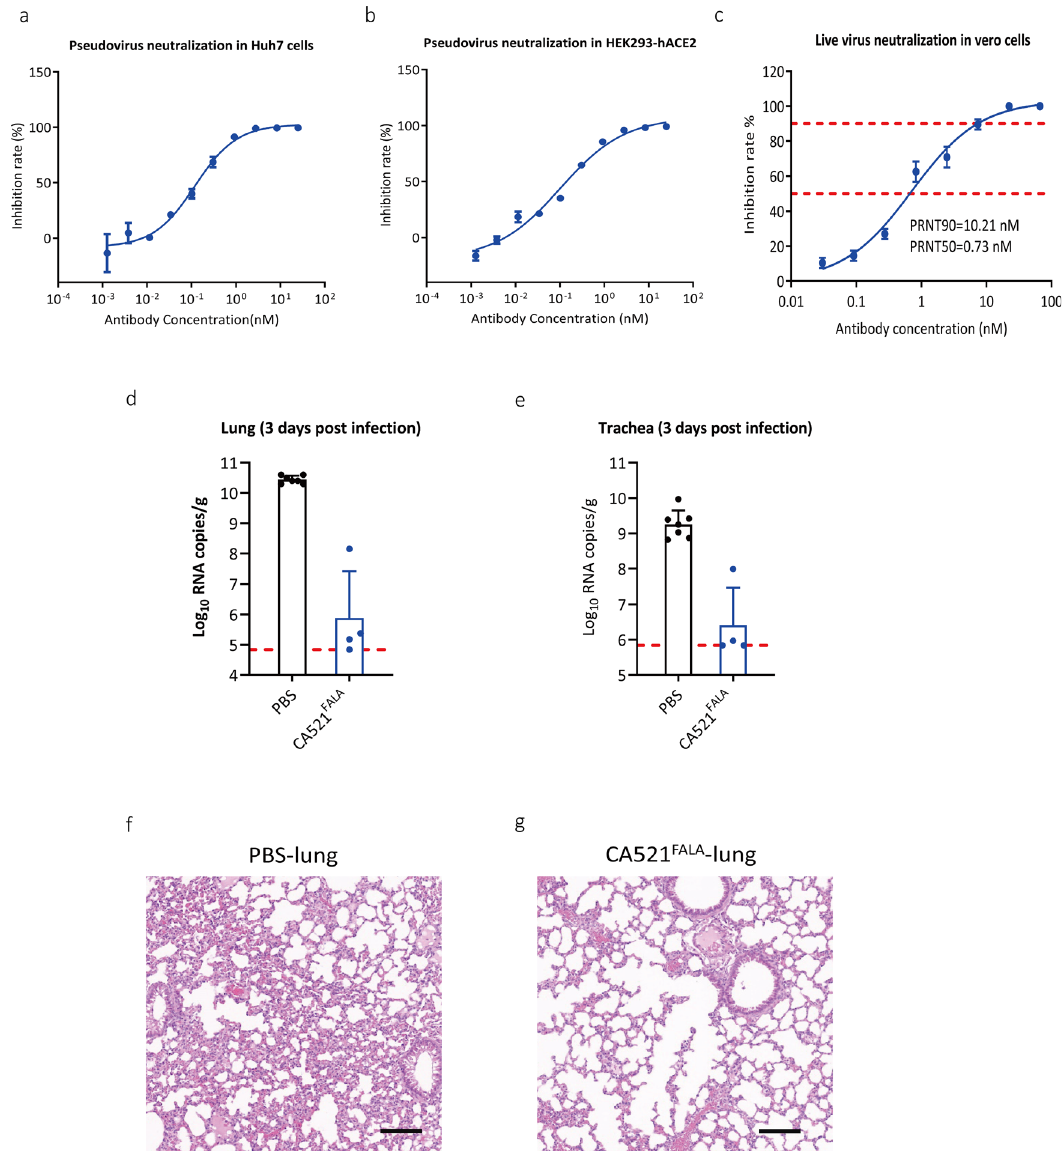
Fig. 3 CA521 FALA inhibited SARS-CoV-2 infection in vitro and in vivo. a CA521 FALA inhibits SARS-CoV-2 pseudovirus infection into Huh7 cells. b CA521 FALA inhibits SARS-CoV-2 pseudovirus infection into hACE2 expressing HEK293T cells. c CA521 FALA inhibits an authentic SARS-CoV-2 strain (BetaCoV/Beijing/IMEBJ01/2020) infection into Vero cells in vitro. Neutralizing activity of mAbs was measured using a standard plaque reduction neutralization with Vero cells. PRNT50 values were determined using non-linear regression analysis. d , e CA521 FALA exited therapeutic ef fi cacy in SARS- CoV-2 susceptible mice. BALB/c mice who received a SARS-CoV-2 mouse-adapted strain (MASCp6) challenge were administered intraperitoneally with a single dose of 20 mg/kg of CA521 FALA ( n = 4) or PBS ( n = 6) in a therapeutic setting. The level of viral RNA was detected in the lung ( d ) and trachea ( e ) at 3 days post infection (3dpi) with a Quantitative PCR assay. f , g Histopathological analysis of lung samples from PBS group or CA521 FALA group at 3 dpi. Scale bar: 100 μ this a single intravenous injection dose of CA521 FALA was given to C57BL/6 mice ( N = 4) and rhesus monkeys ( N = 3) at 10 and 50 mg/kg. ELISA was used to determine the concentration of CA521 FALA in serum. Following a single-dose 10 mg/kg intra- vascular injection in C57BL/6 mice, CA521 FALA showed a bi- tribution phase followed by a long elimination phase, with a terminal half-life ( t 1/2 , λ z ) of 9.5 ± 4 days, C max of 96 ± 5 μ g/mL